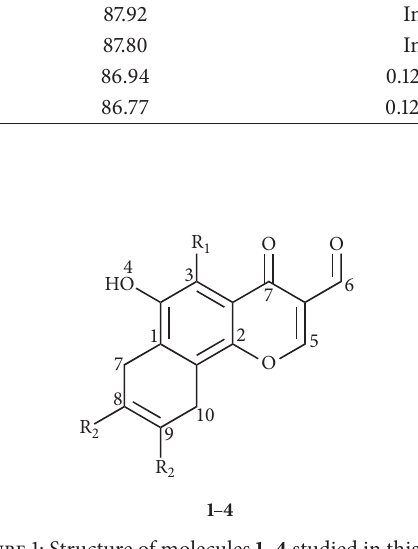
Figure 1: Structure of molecules 1 – 4 studied in this